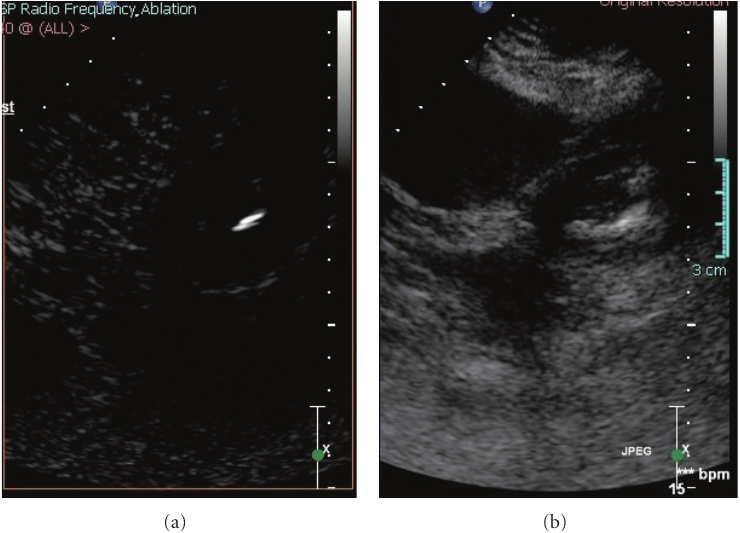
Figure 3: Ultrasound contrast image and grey scale ultrasound show the lack of the perfusion of solid mass with central needle (a) and now increased echoes in tumor from ablation